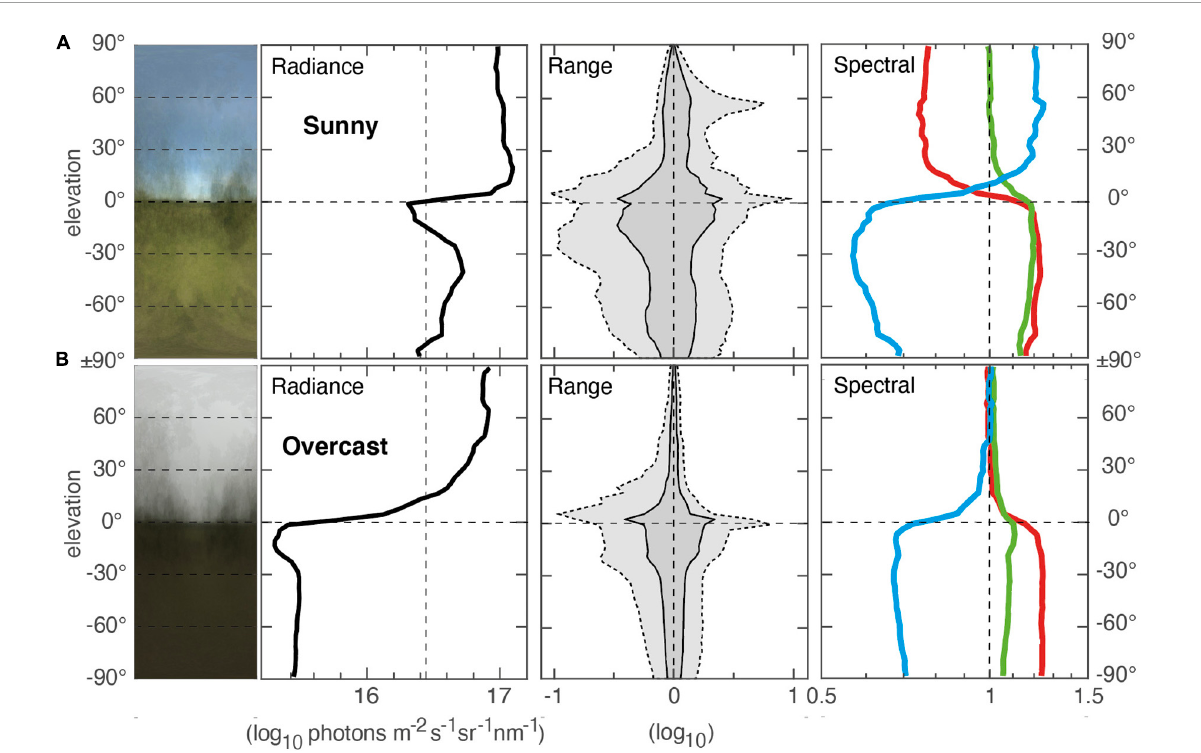
FIGURE6 Vertical light gradients in a semi-open environment near Dalby, southern Sweden measured in clear sunny conditions (A) and overcast conditions (B) . Measurements were based on 21–25 scenes, sampled on 21 July 2016, start 13:30 m, duration 7 min (A) and 17 September 2016, start 12:44, duration 6 min (B) . A single scene at another environment, recorded at sunny, partially cloudy and fully overcast is provided in Supplementary Figure S4 .